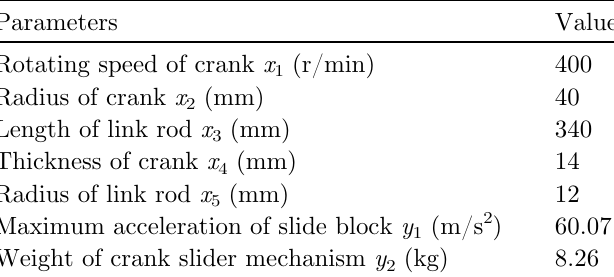
Table 3. Optimized